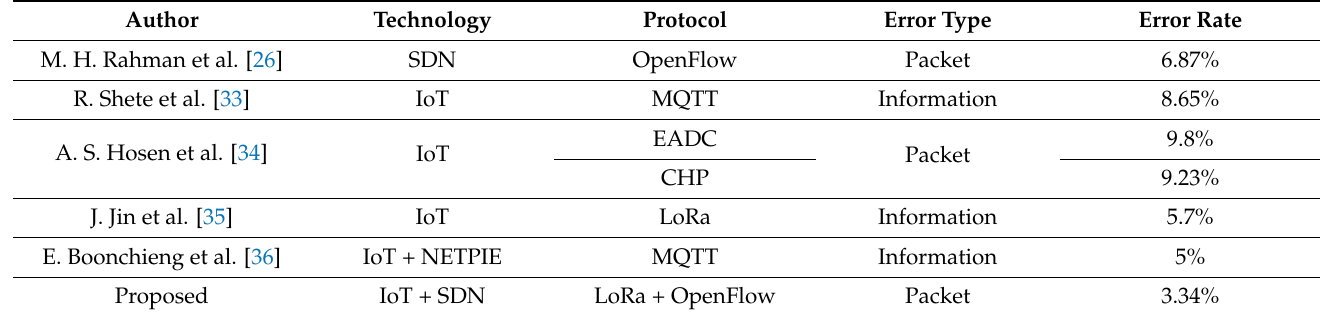
Table 3. Comparison of error rate for the use of different